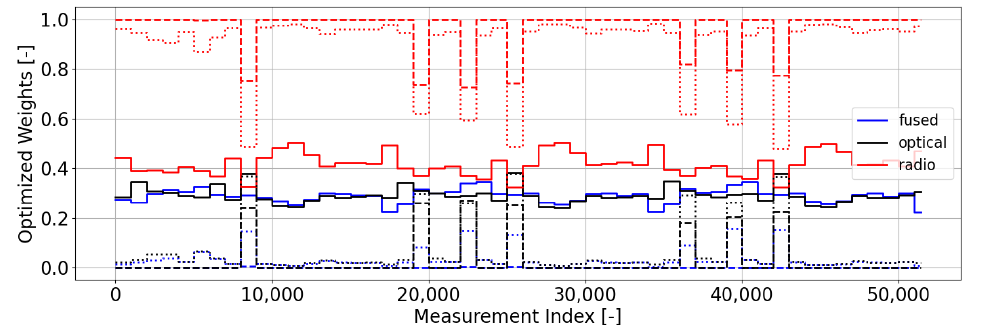
Figure 11. Optimal gating network weights with biased optical measurements. Small (solid lines), medium (dotted lines), and large (dashed lines) biasing cases are included.